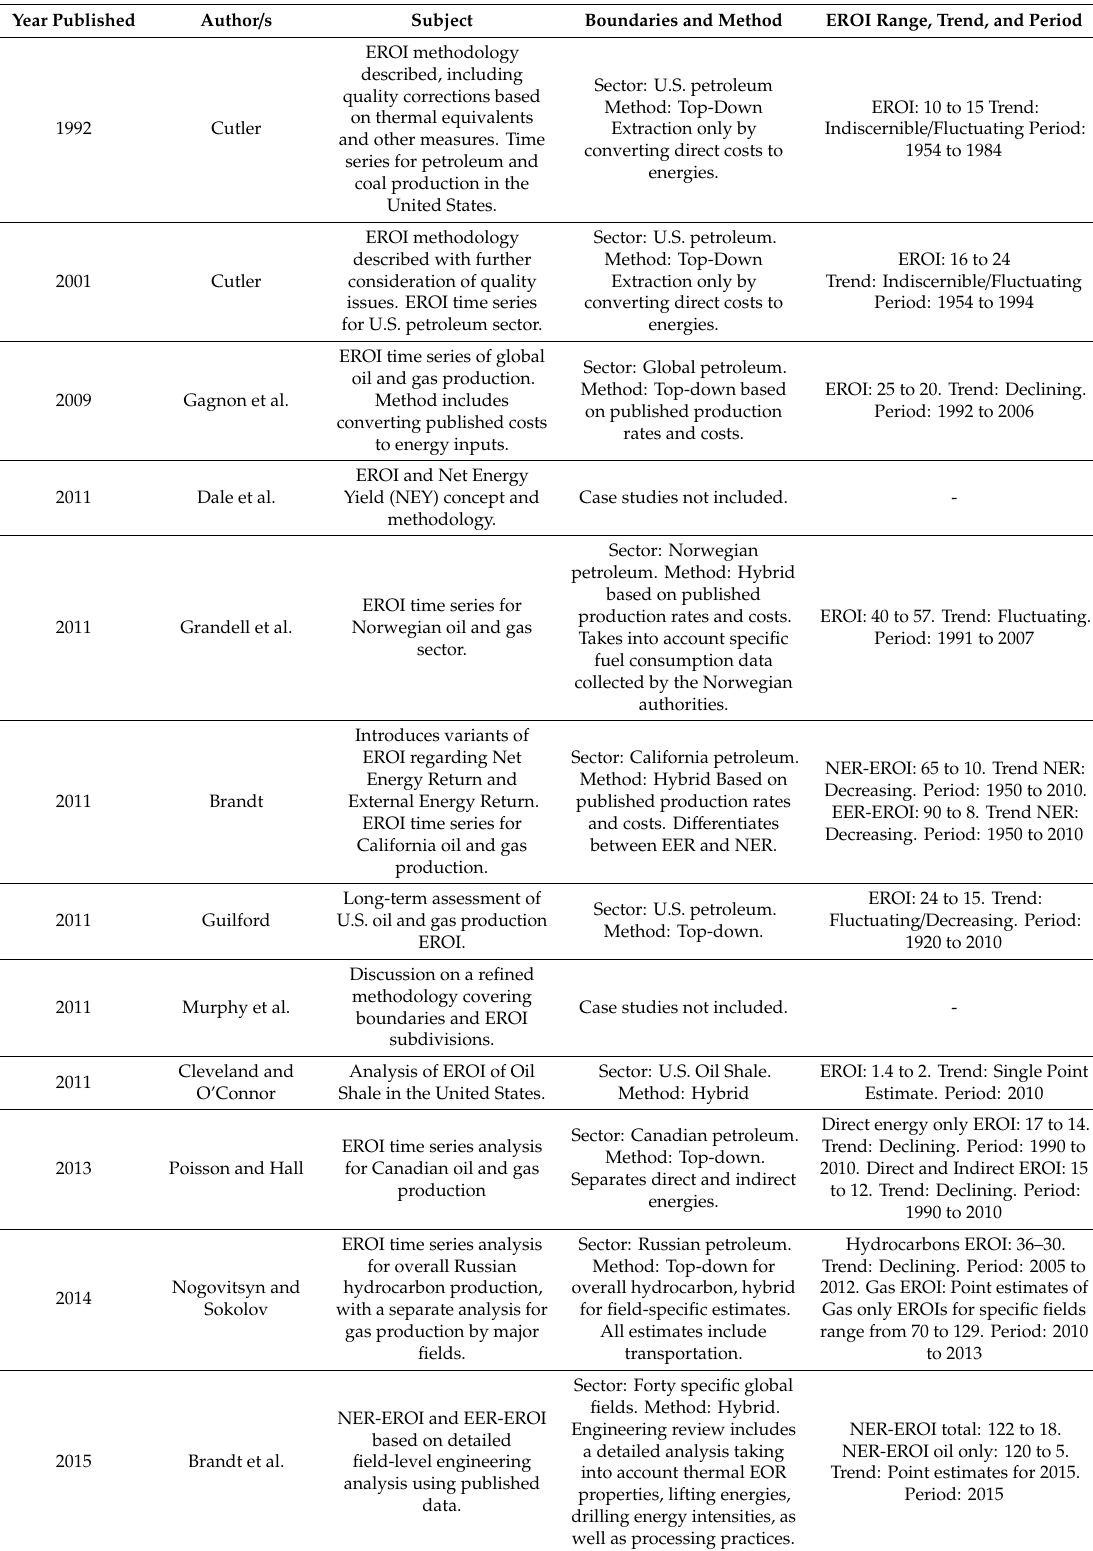
Table 3. Summary of EROI